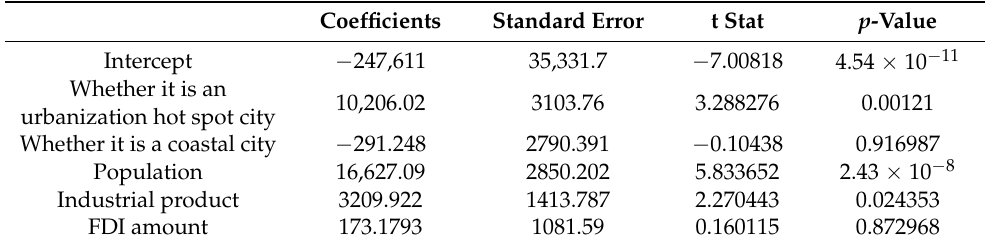
Table 2. Analysis of driving factors of urbanization in